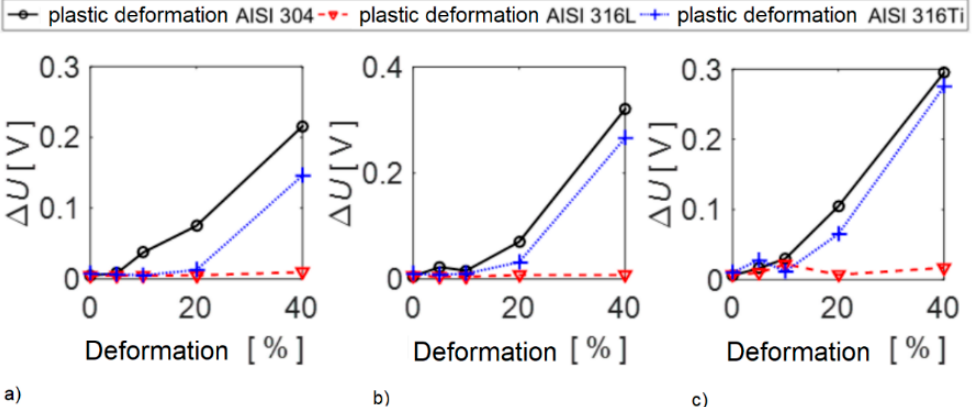
Figure 17. Dependence of the change in the voltage response of the sensor on the degree of deformation—( a ) top base, ( b ) shell surface, ( c ) bottom base.